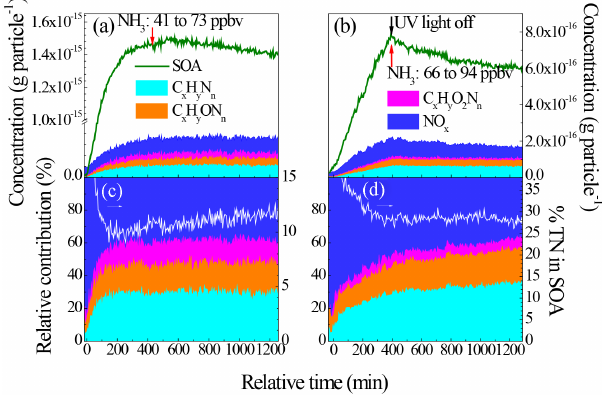
Figure 3. Concentration changes for N-containing fragments and SOA for (a) ozonolysis of α -pinene (Exp. P6) and (b) OH oxidation of m -xylene (Exp. M16), respectively; the relative fraction of each species to total NOC mass ( T NOC = C x H y N + C x H y ON + C x H y O 2 N + NO x ) and T NOC to SOA fraction for (c) ozonolysis of α -pinene and (d) OH oxidation of m -xylene,